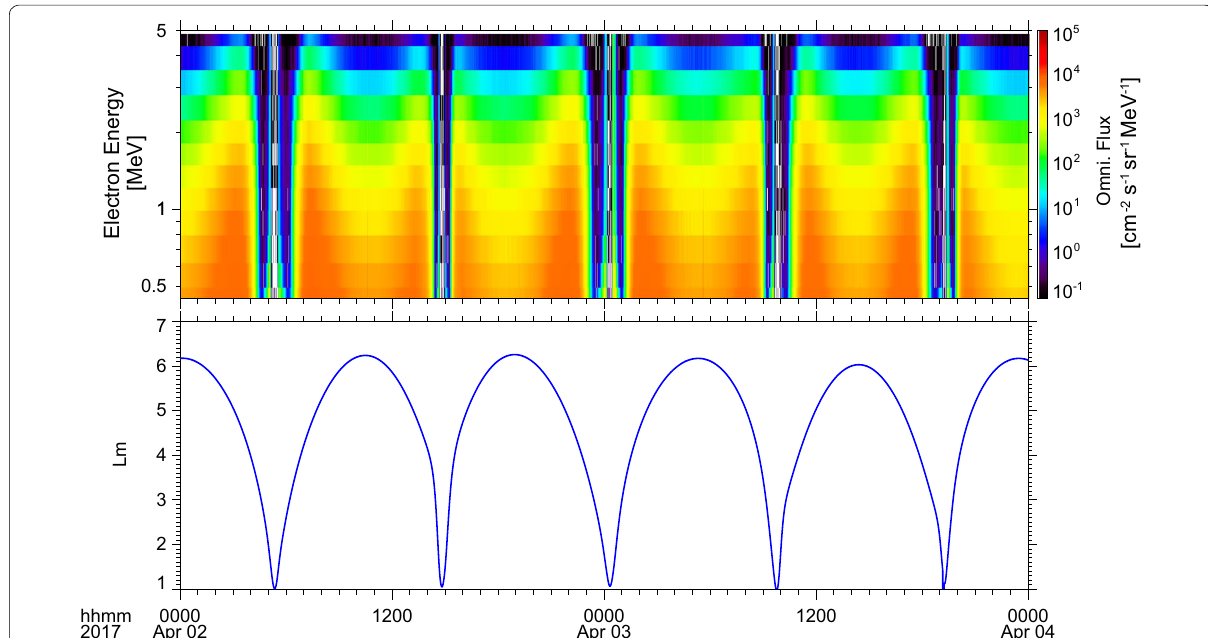
Fig. 11 An energy–time diagram of energetic electron fluxes observed by XEP during the two-day interval after April 2, 2017. The bottom panel shows the McIlwain L -parameter ( L m ) for a pitch angle of